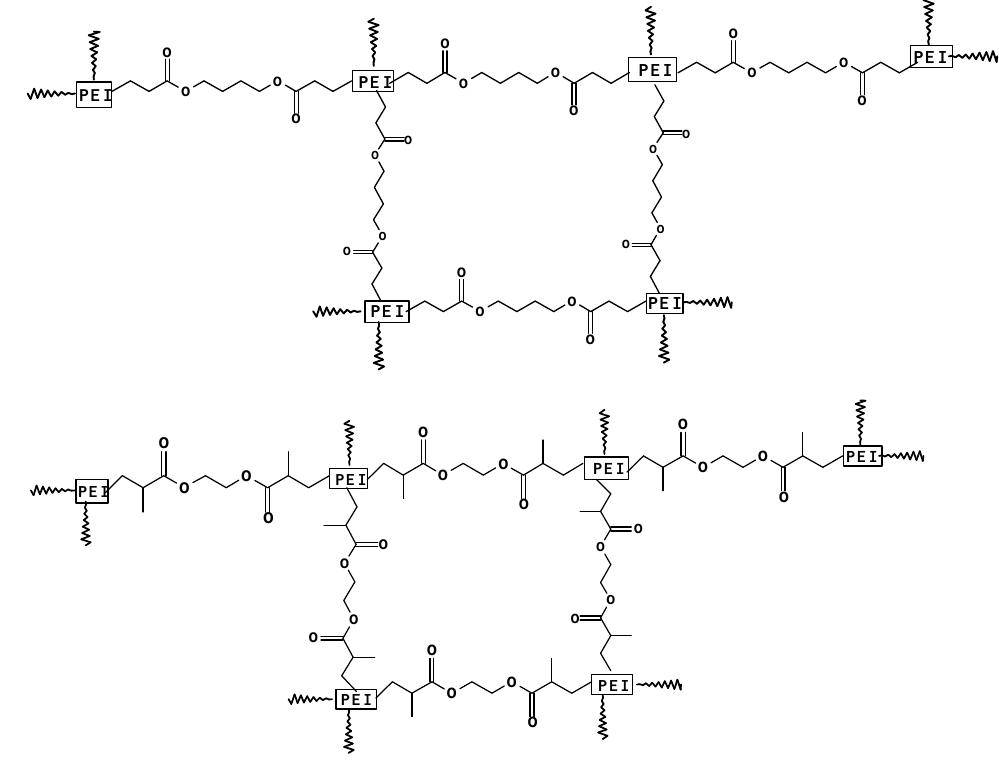
Figure 1. Synthesis of cross linked PEIs and their structural illustration . (A) 2000-Da PEI is reacted with diacrylates (BDDA or EGDMA shown) to generate the ester-cross-linked polymers. (B) The acrylate groups can react with either primary or secondary amines, resulting in a highly branched